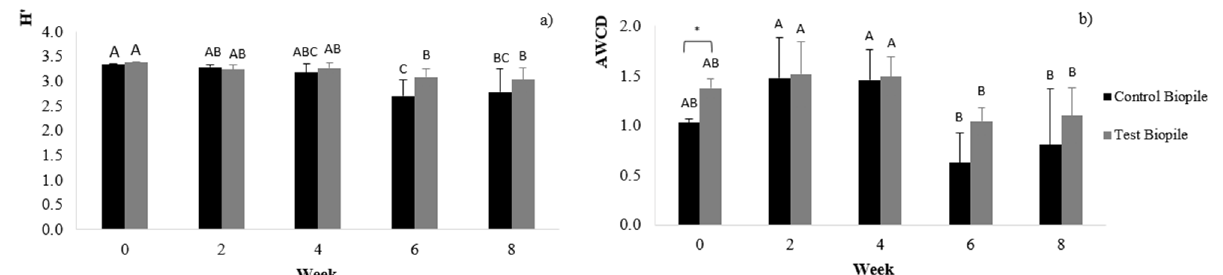
Figure 4. ( a ) Evolution of the Shannon–Weaver index (H′, n = 3), and ( b ) evolution of the global microbial activity (AWCD: average well color development, n = 3). Different letters indicate a significant difference between plots according to the Kruskal–Wallis test with Dunn’s procedure; p value = 0.05 for ( a ); p value > 0.05 for ( b ); and * indicates a significant t -test result, α = 0.001.